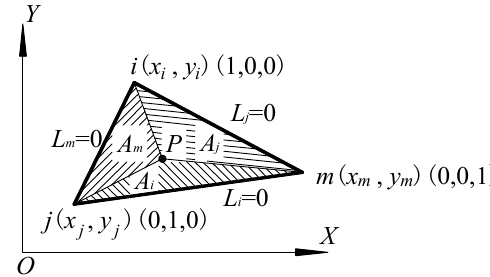
Figure 3. Area coordinate system of triangles.